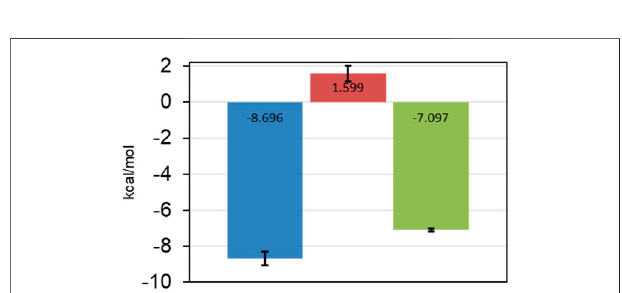
FIGURE 7 | Thermodynamic parameters of 9595 determined from quadruplicate in the ITC. Δ H in blue, − T Δ S in red, and Δ G in green. Standard deviations areshown aserror bars. Thefragmentismostlyreliantonenthalpic effects for the binding mode.